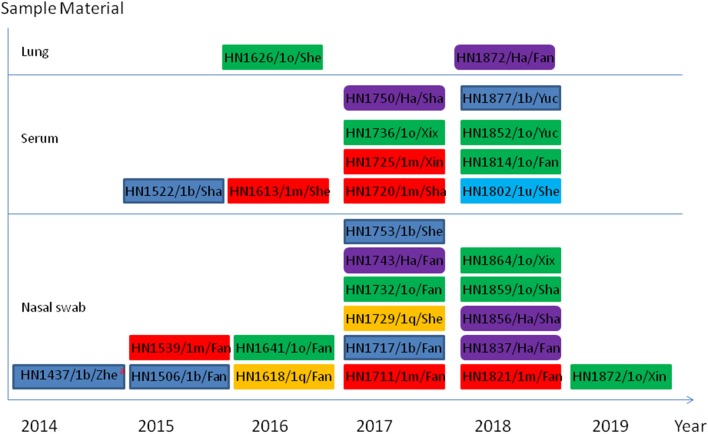
Schematic representation of 29 bovine Pestivirus positive in this work. aindicate the information of sample including sample number/genotype/county. The county names: Zhe, Zhenping; Fan, Fangcheng; Sha, Shangcai; She, Sheqi; Xin, Xinye; Xix, Xixia; Yuc, Yucheng. The blue rectangle represents Peativirus A 1b genotype; the red rectangle represents Peativirus A 1m genotype; the yellow rectangle represents Peativirus A 1q genotype; the green rectangle represents Peativirus A 1o genotype; the light blue rectangle represents Peativirus A 1u genotype; the purple rounded rectangle represents Peativirus H a genotype.